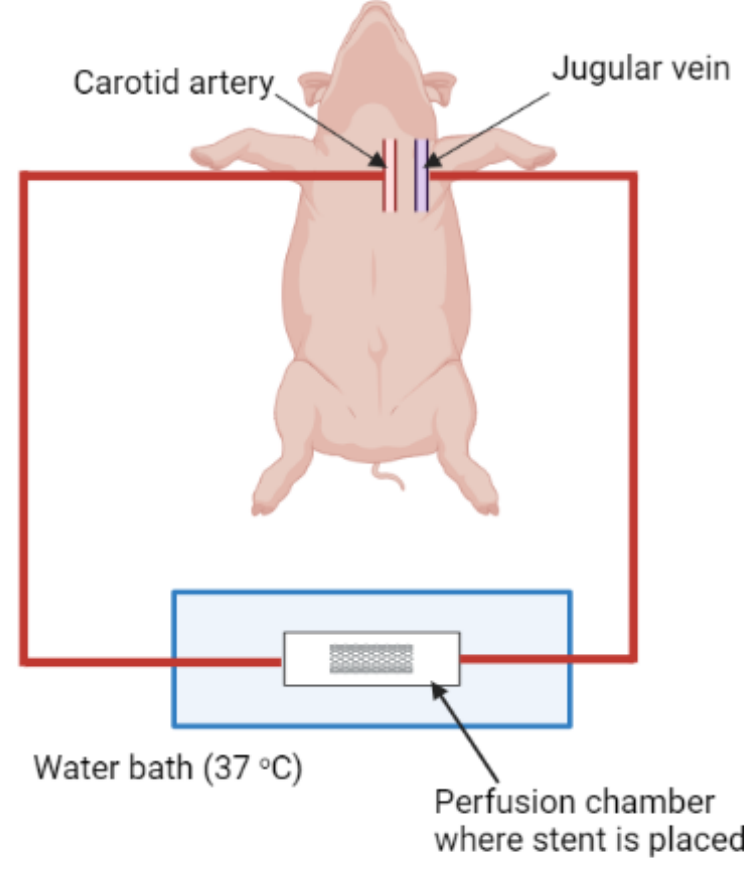
Figure 6. A diagram of porcine AV shunt model (Created with BioRender.com).